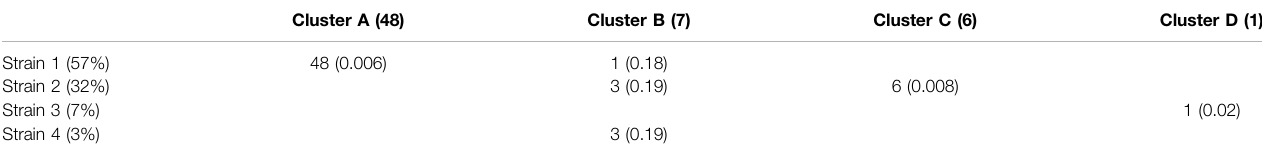
TABLE2| ConcordanceamongSCGsofclusterassignmentsandtheclosest-matchStrainFactsinferredgenotype,amongthefourstrainsinferred tobeatgreaterthan1% relativeabundanceintheanalysedsample.ThetotalnumberofSCGsineachclusterandtherelativeabundanceofeachinferredstrainareindicatedinparenthesesinthe column and row labels, respectively. Numbers in each cell indicate the number of SCGs at that intersection and values in parentheses indicate the median normalized Hamming distance of those SCGs to the inferred strain